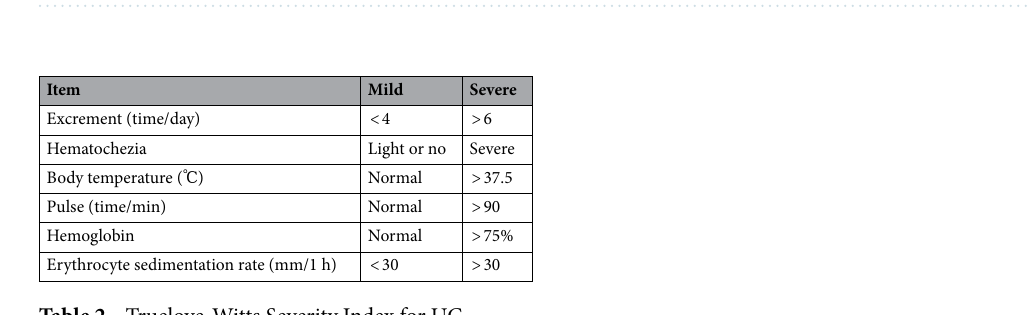
Table 2. Truelove-Witts Severity Index for UC.